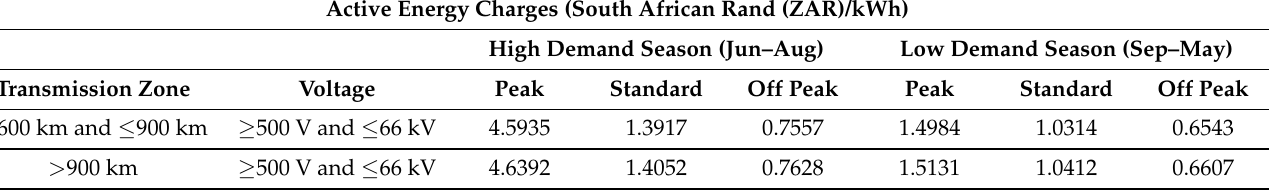
Table 7. Urban Megaflex non-authority tariff charges (excluding VAT) [38].